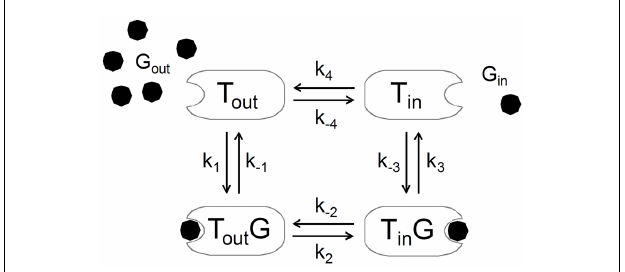
FIGURE 10 |The alternating-conformation kinetics of the glucose carrier . In the absence of glucose ( G out or G in ), the carrier can exist in two inter-converting isomers that are ready to bind glucose either outside ( T out ) or inside ( T in ) the membrane.When loaded, the carrier can also assume two isomeric forms favoring glucose release to the outer ( T out G ) or inner ( T in G ) side of the membrane.The rate constants k 1 and k − 3 define glucose binding while k − 1 and k 3 define its dissociation from the carrier.The rate constants k 2 and k − 2 or k 4 and k − 4 reflect the isomerization of the loaded or unloaded